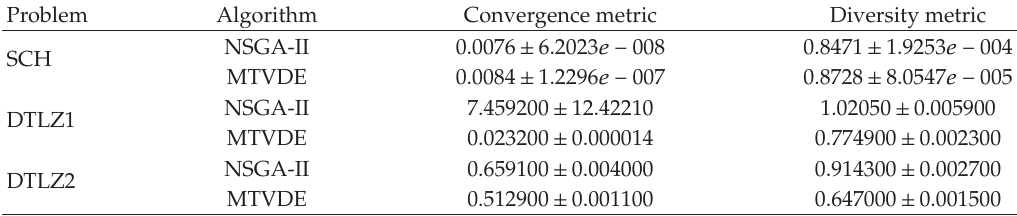
Table 6: Testing result’s statistics of the problems SCH, DTLZ1, and